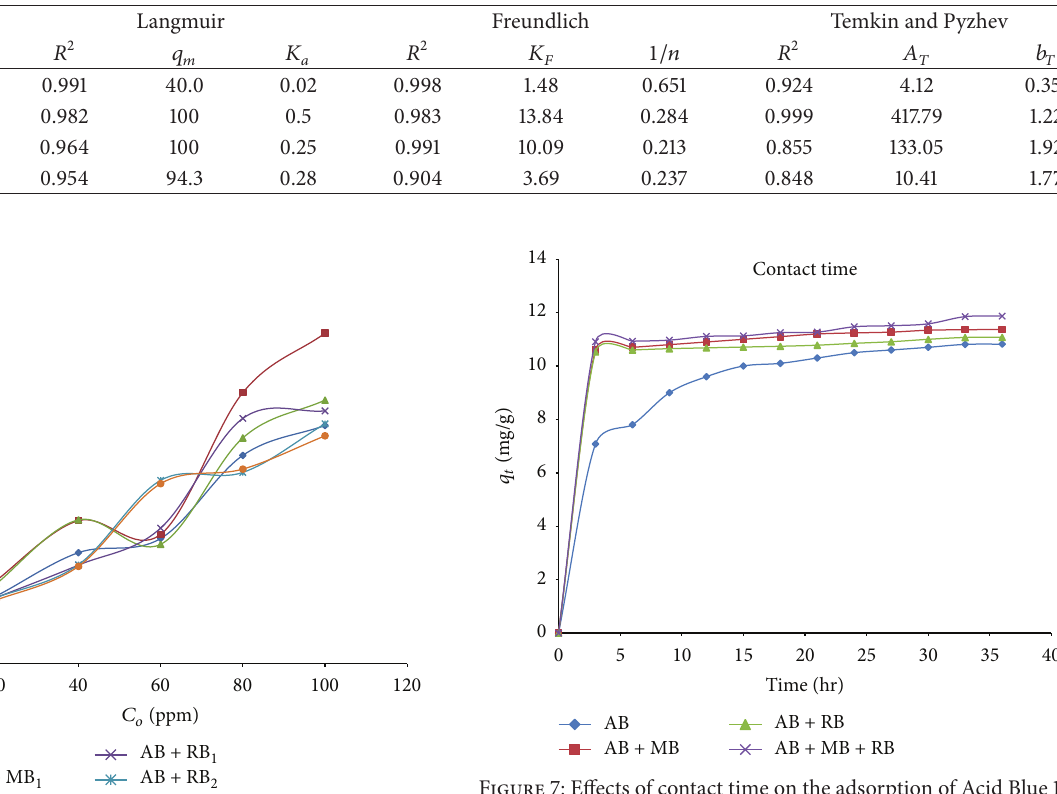
Figure 7: Effects of contact time on the adsorption of Acid Blue 161 on raw